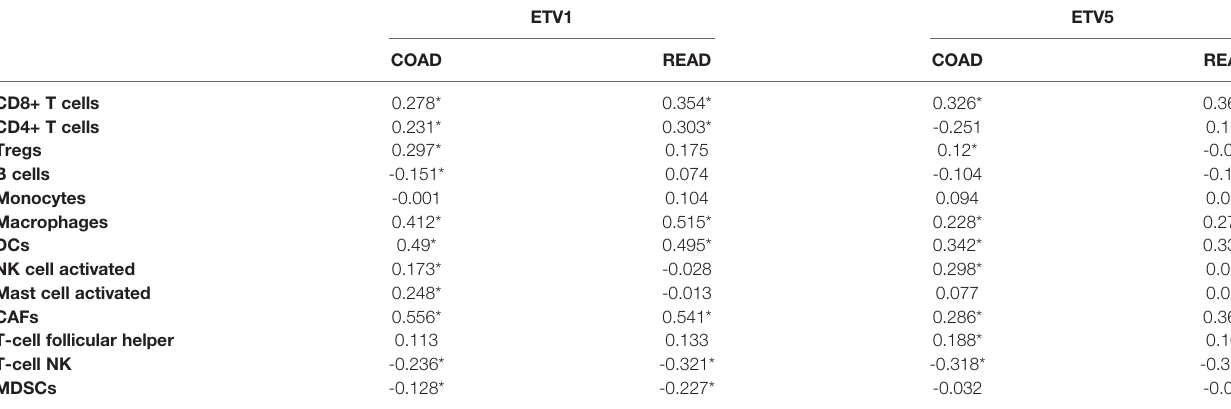
TABLE 2 | Correlation analysis among ETV1 and ETV5 and immune cells in TIMER.